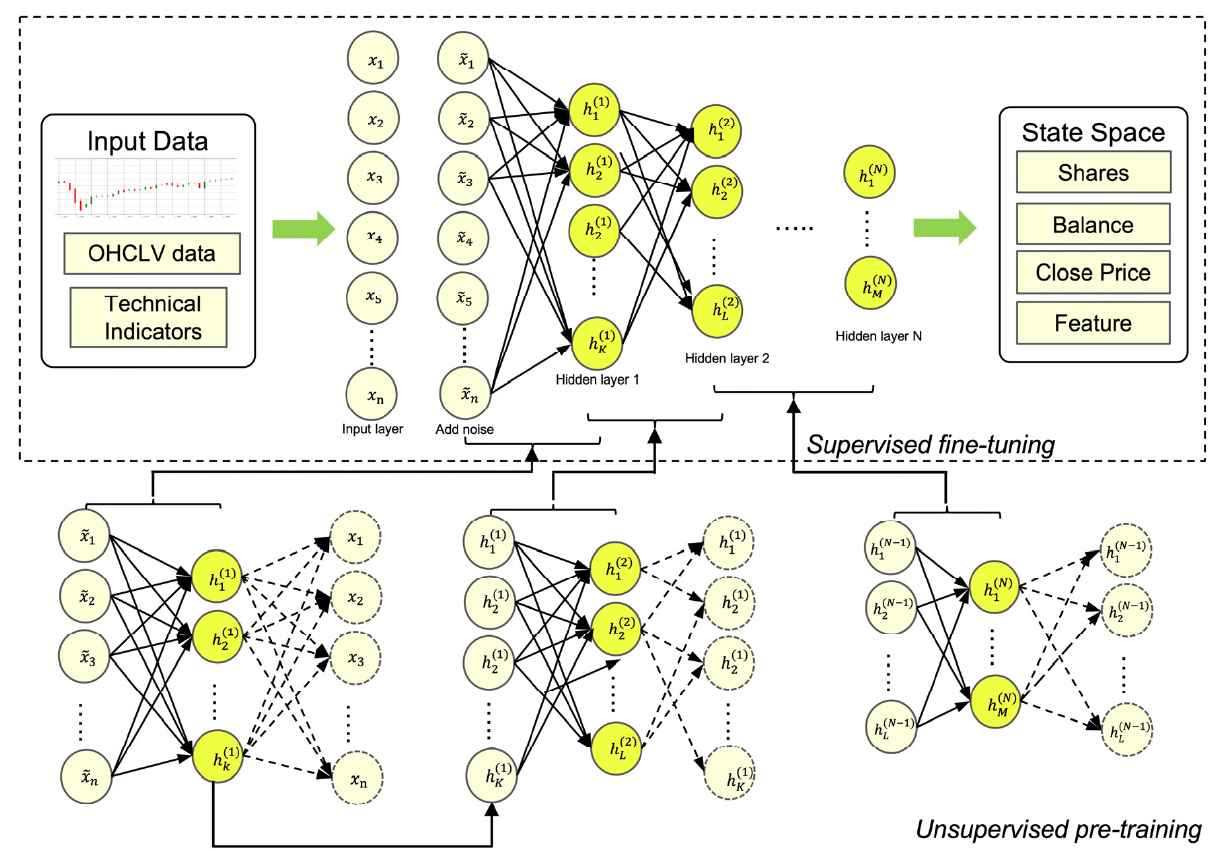
Figure 1. The structure of SSDAE autoencoder network.